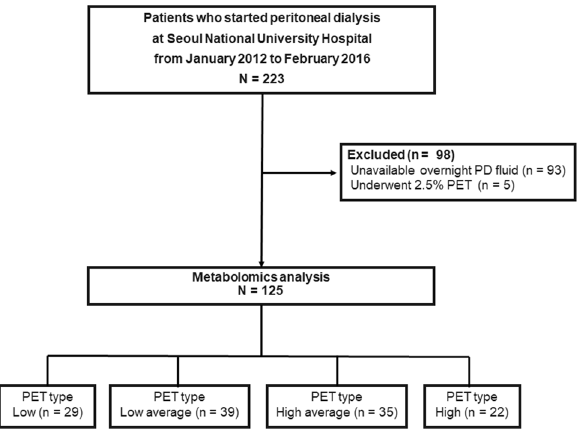
Figure 1. Patients in the study analyses. PD peritoneal dialysis, PET peritoneal equilibration